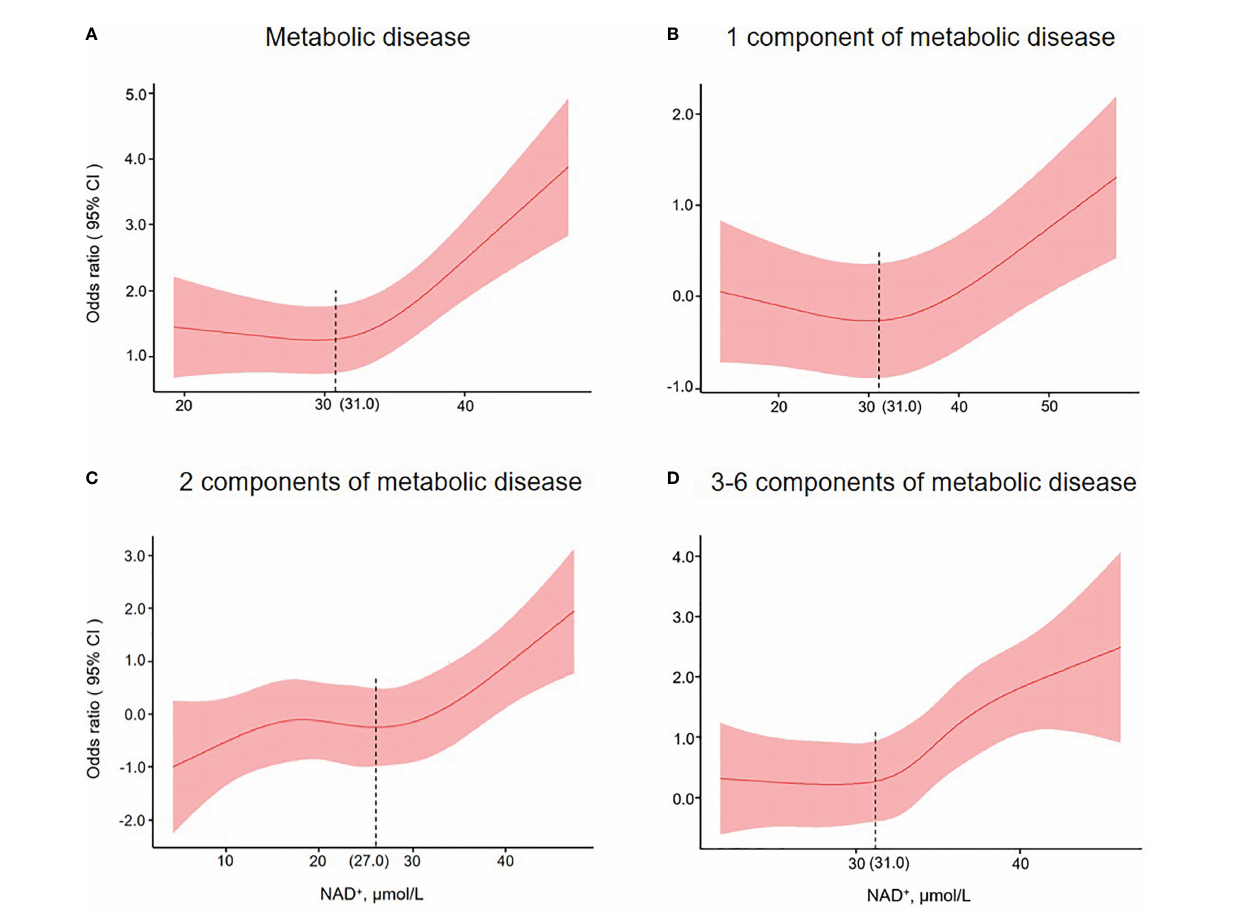
FIGURE 3 Restricted cubic spline plots for associations of NAD + levels with metabolic disease (A) , 1 metabolic disease component (B) , 2 metabolic disease components (C) , and 3-6 metabolic disease components (D) in the population of interest. Models were adjusted for age, gender, the number of RBCs, smoking, drinking, exercise, education, and meat. The red line and shaded area represent the odds ratios and corresponding 95% con fi dence